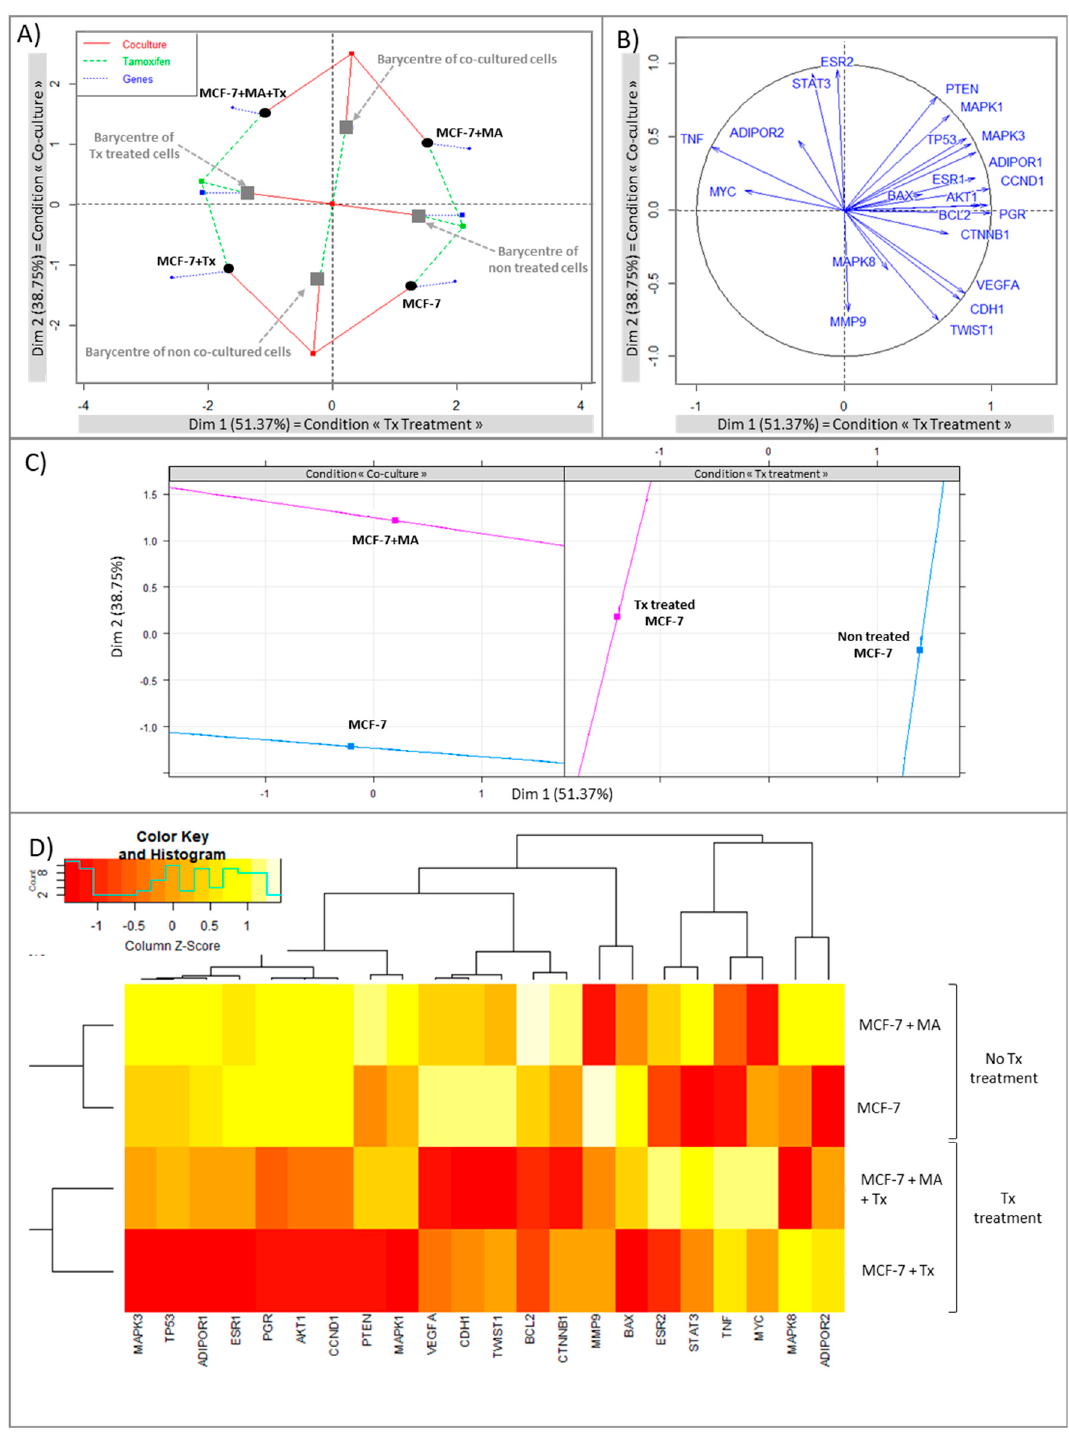
Figure 3. Multiple factor analysis leading to ( A ) individual factor map, ( B ) circle correlation, ( C ) Multiple factor analysis resume, ( D ) heatmap with hierarchical clustering (red for under-expressed, orange for unchanged expression, and white for over-expressed genes). Dimension 1: “Tx Treatment”; Dimension 2: “co-cultured conditions”.